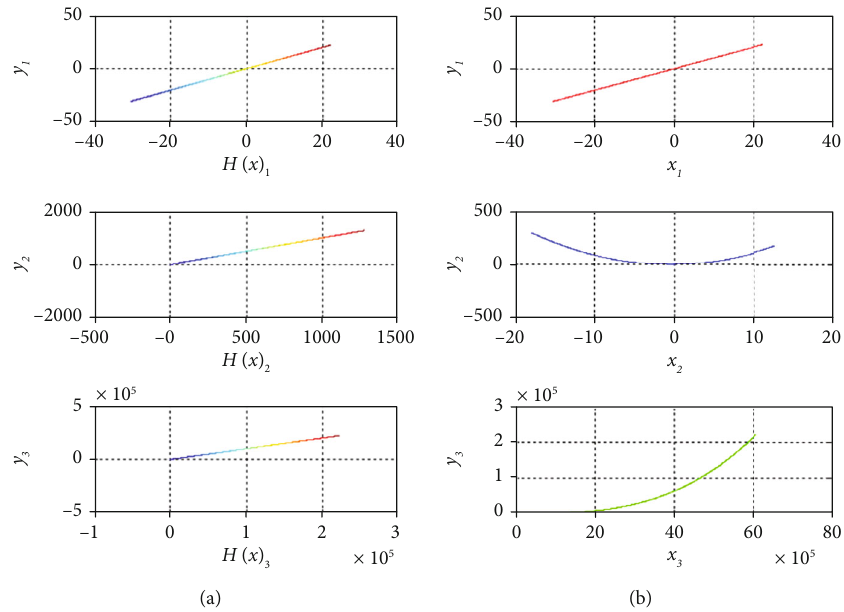
Figure 4: The synchronization relationships of di ff erent state variables in the unidirectionally coupled Chen system. (a) H ð x Þ = ð H ð x Þ Þ T and y = ð y , H ð x Þ , H ð x Þ 1 2 3 synchronization with respect to the high-order polynomial manifold y = ½ x